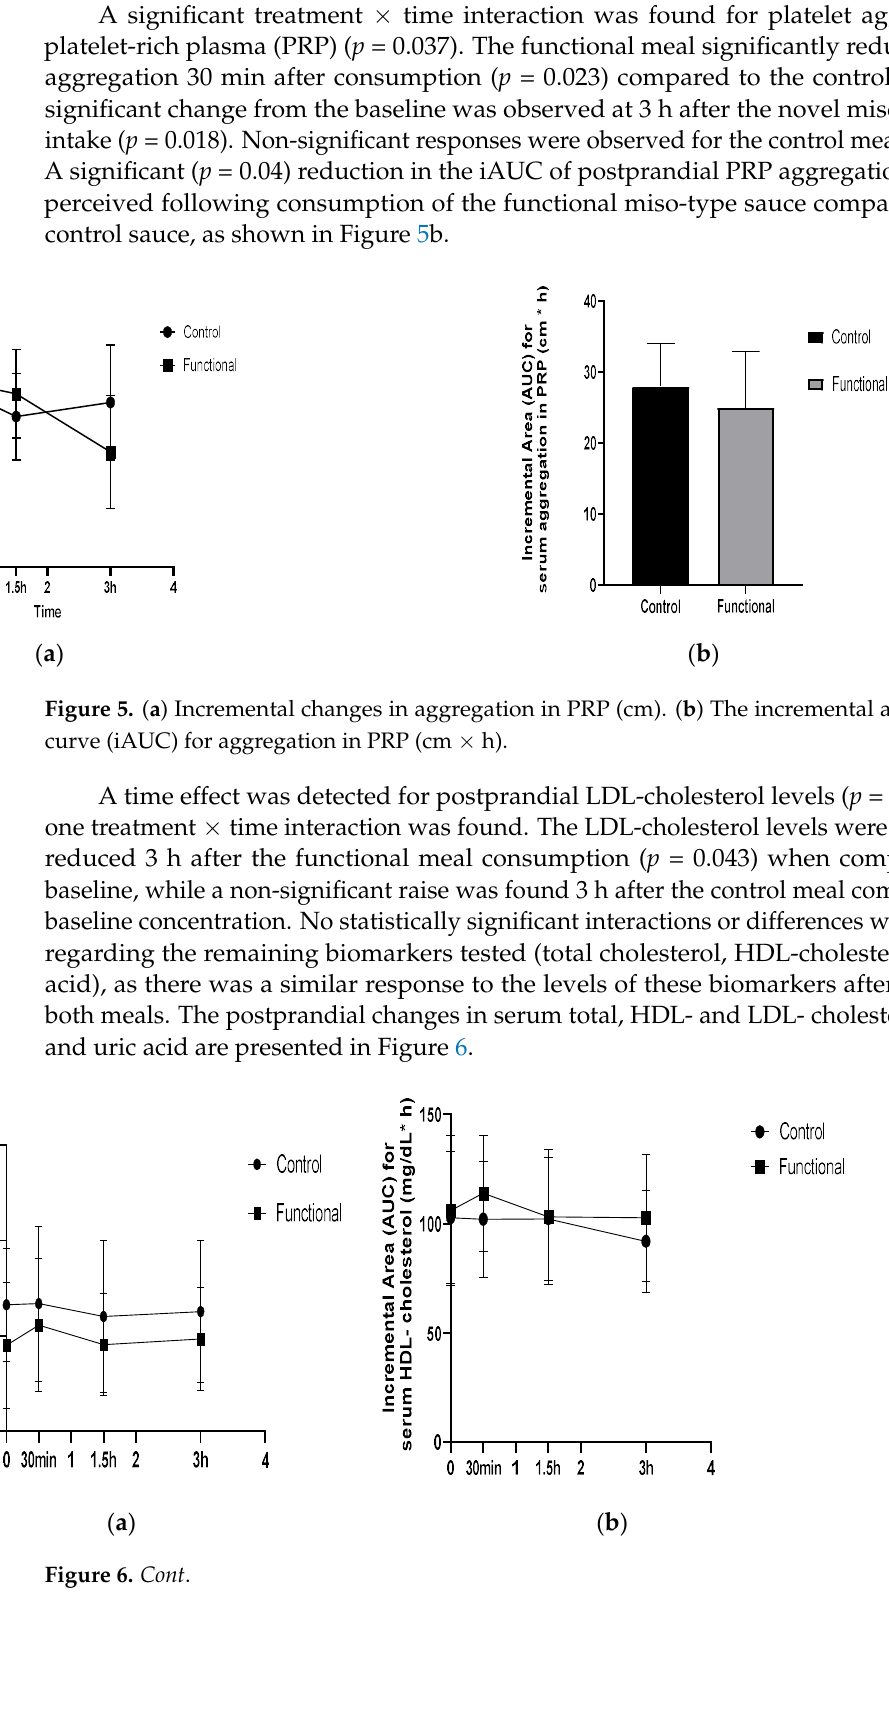
( d ) ( e ) Figure 6. ( a ) Incremental changes in postprandial total cholesterol concentration . ( b ) Incremental changes in postprandial HDL-cholesterol concentration. ( c ) Incremental changes in postprandial LDL-cholesterol concentration. ( e ) Incremental changes in postprandial uric acid concentration. Table 3 summarizes postprandial responses of serum lipids, glucose, aggregation, and plasma TAC, following a high-carbohydrate and fat meal, containing a novel miso-type or a control sauce.